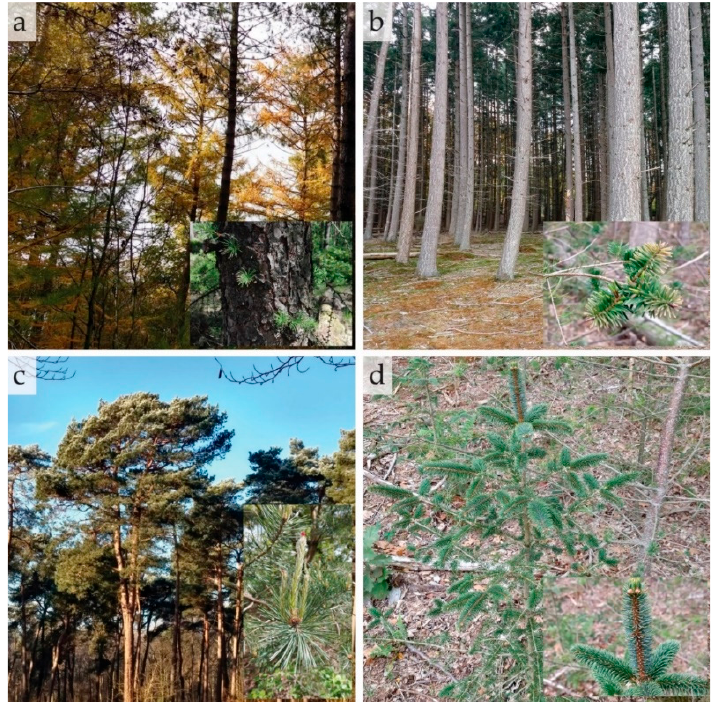
Figure A1. The general habitat appearance and foliage of the four angiosperm tree species used in the analysis with ( a ) silver birch ( Betula pendula ), ( b ) European beech ( Fagus sylvatica ), ( c ) common oak ( Quercus robur ), and ( d ) northern red oak ( Quercus rubra ). All photographs were made by the authors.